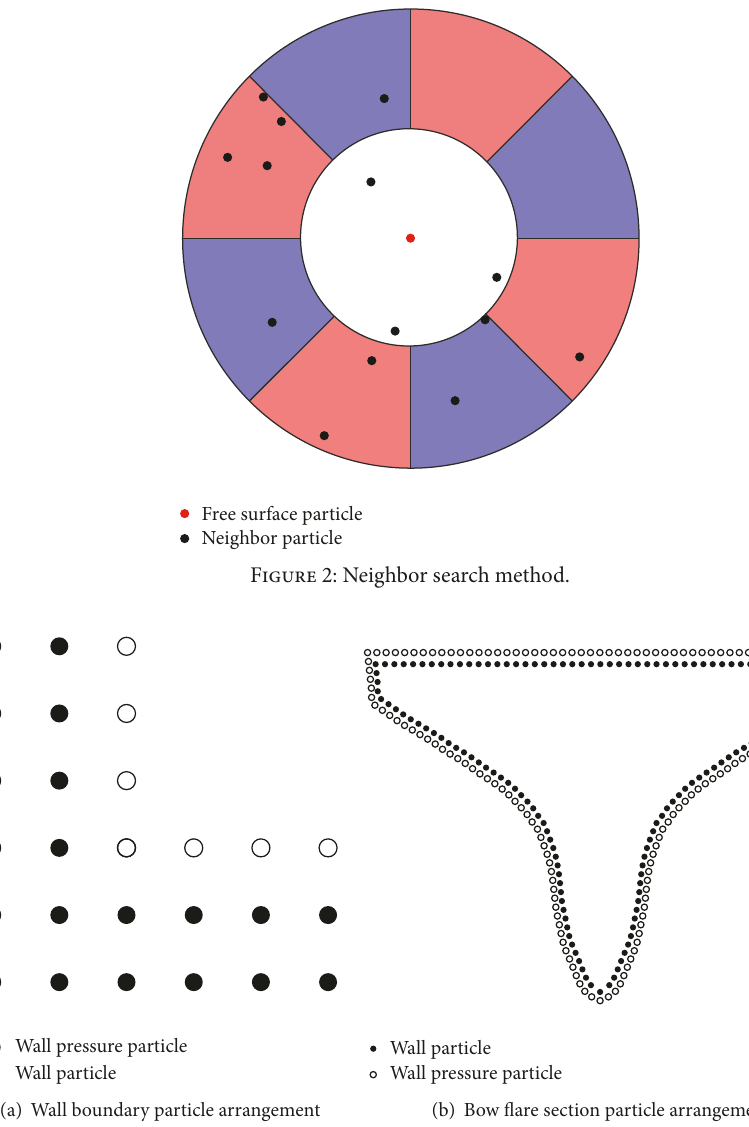
Figure 3: Fluid-solid boundary.